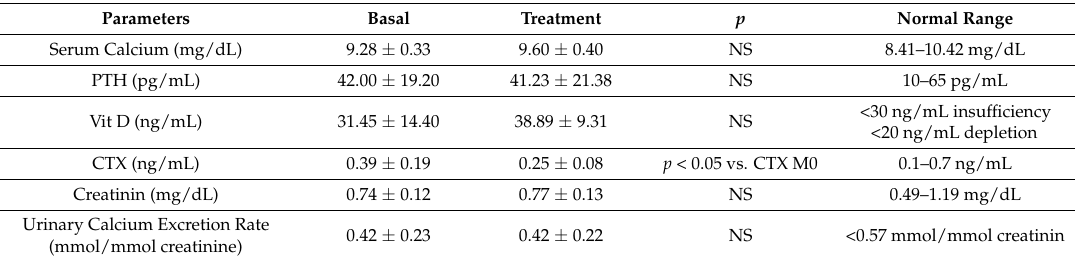
Table 1. Biochemical data.